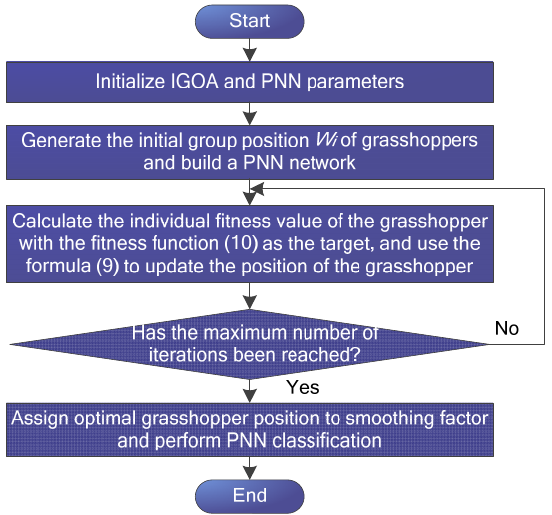
Figure 3. IGOA-PNN flowchart.